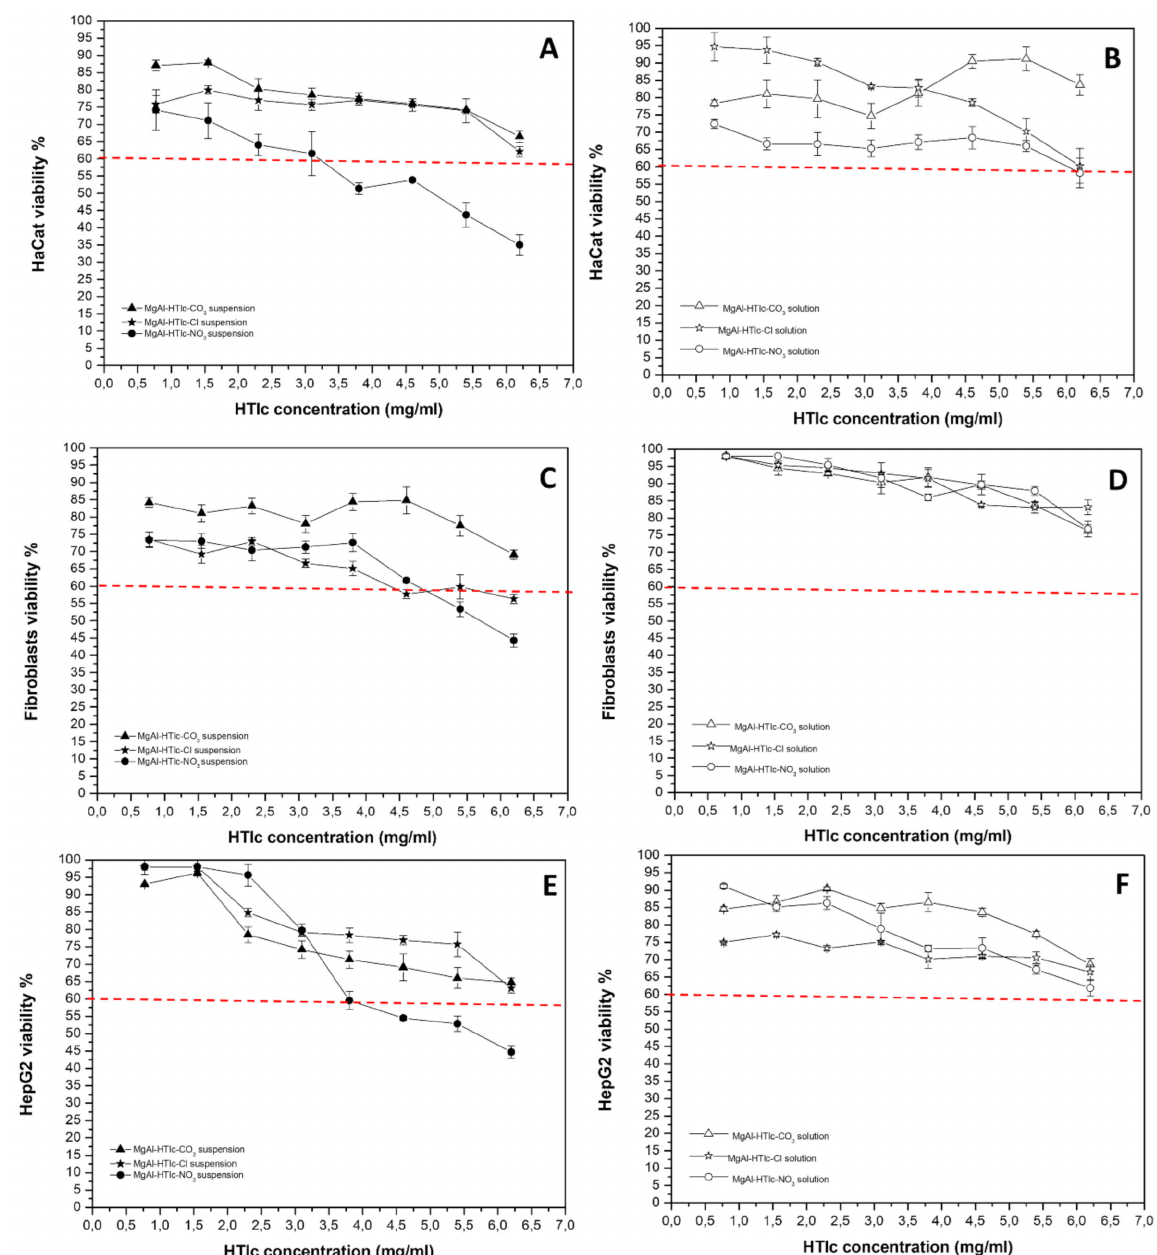
Figure 5. Viability of HaCat cells incubated with MgAl-HTlc suspensions ( A ) and supernatants ( B ); viability of fibroblasts incubated with MgAl-HTlc suspensions ( C ) and supernatants ( D ); viability of HepG2 cells incubated with MgAl-HTlc suspensions ( E ) and supernatants ( F ). The percentage of viable cells with respect to the control was reported as the mean ± SD of five independent experiments. Dotted lines indicate 60% cell